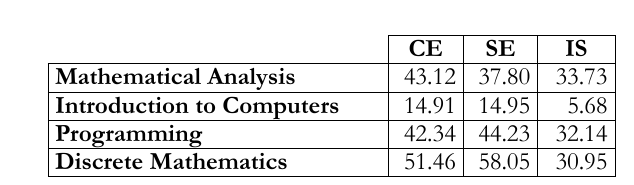
Table 1. Efficiency rates for courses common to all three